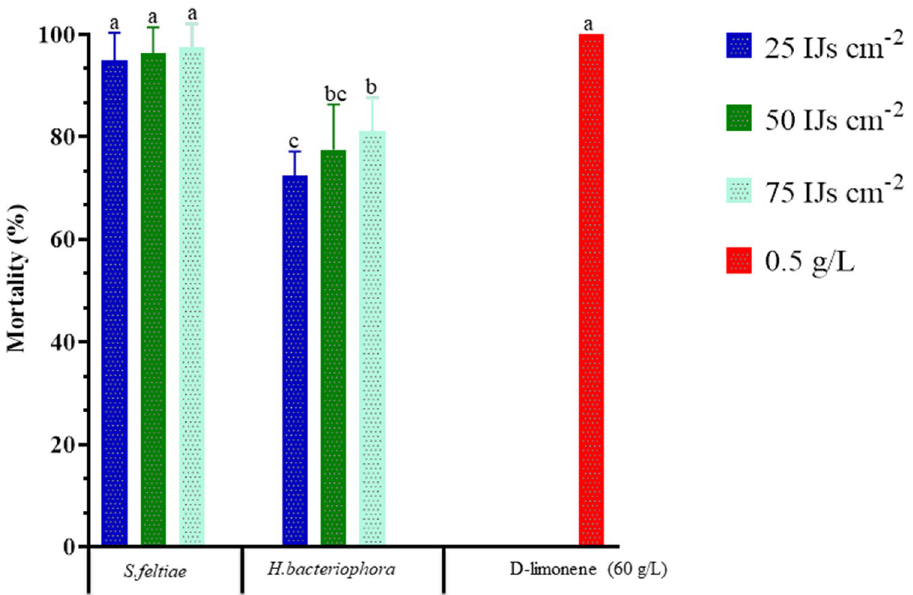
Figure 2. Comparative efficiency of different entomopathogenic nematodes isolates Steinernema feltiae and Heterorhabditis bacteriophora with d-limonene against Dactylopius opuntiae young females, in laboratory assay. Datasets are the mean of two independent trials with four relicates. Treatments with the same letter are not significantly different according to Tukey’s LSD test at P <